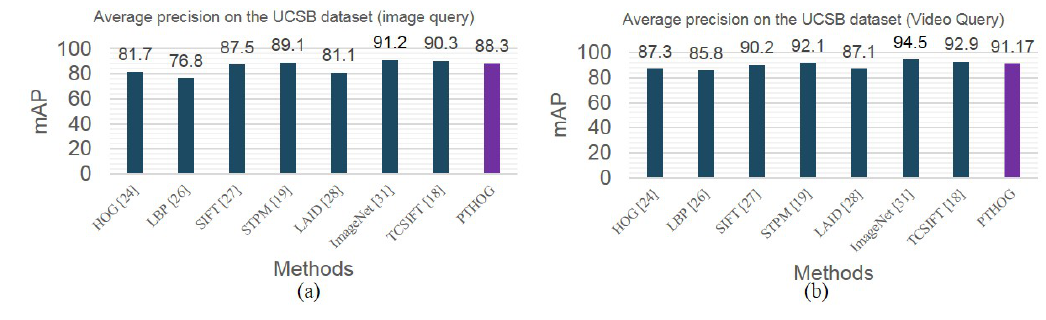
Figure 9. ( a ) Comparison with existing approach on the UCSB dataset for image query and ( b ) Comparison with existing approach on the UCSB dataset for video